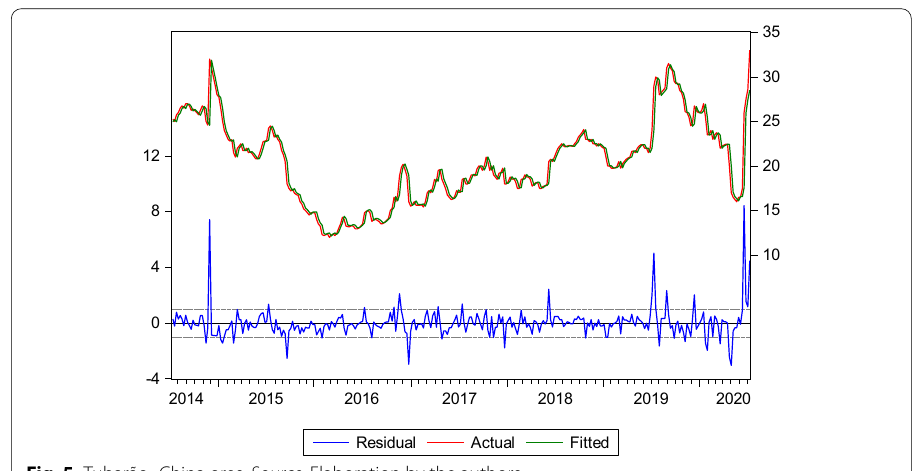
Fig. 5 Tubarão–China ores. Source : Elaboration by the authors